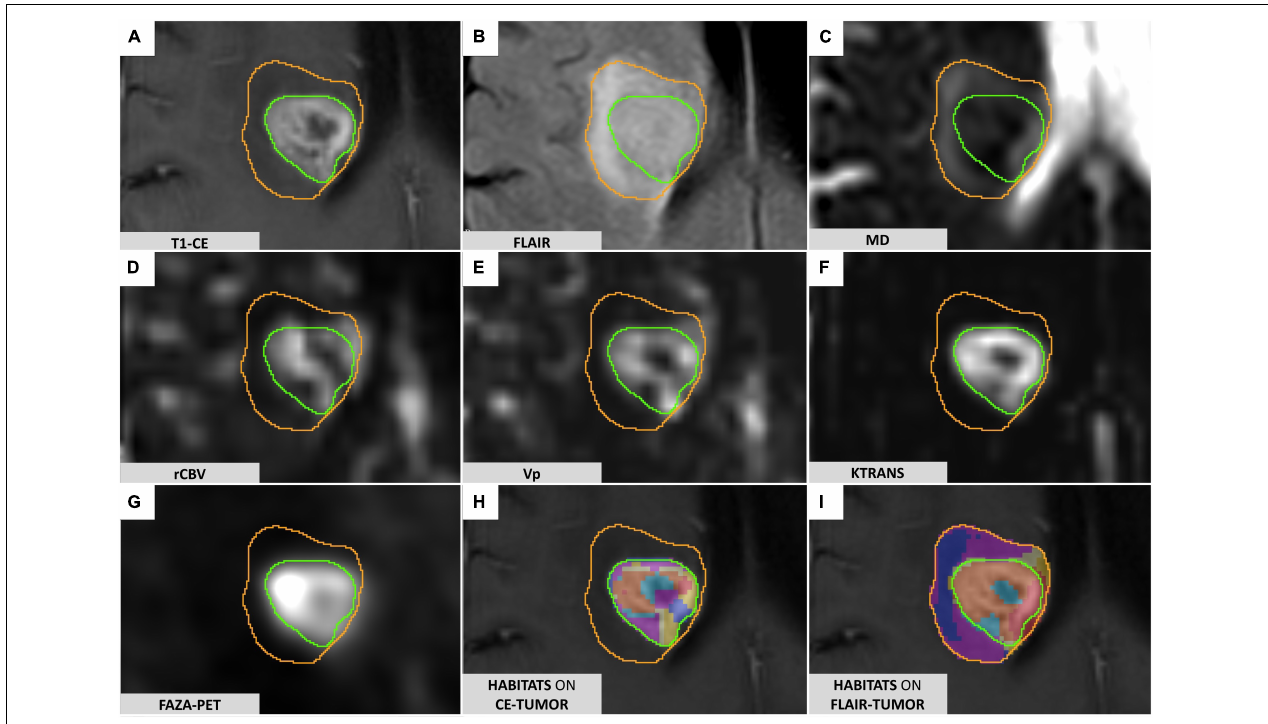
FIGURE 1 | FLAIR-tumor and CE-tumor segmentations on different MRI sequences. (A) T1-weighted contrast-enhanced imaging: the CE-tumor volume is contoured in green, including the enhancing tissue and necrotic core only. (B) FLAIR images: FLAIR-tumor is contoured in orange, including both the CE-tumor and the peritumoral hyperintensity. (C) MD map elaborated from DTI acquisition. (D) rCBV map elaborated from DSC MR perfusion acquisition. (E) VP map elaborated from DCE MR perfusion acquisition (F) Ktrans map elaborated from DCE MR perfusion acquisition. (G) 18F-FAZA-PET uptake showing hypoxic areas. (H) Prototype of clusters resulting from the application of the spatial habitat imaging algorithm only to the contrast-enhanced tumor volume (CE-tumor); clusters obtained this way were considered too small and fragmented in order to be reliably correlated to histology, and therefore not suitable for the purpose of the present study. (I) Habitats obtained applying the spatial habitat imaging algorithm to the FLAIR-tumor volume (which included the contrast-enhanced tumor core along with the surrounding area of FLAIR hyperintensity) were able to divide the whole tumor in a more reproducible way, with larger clusters amenable to a reliable histological correlation with the bioptic samples obtained; for the aforementioned reasons we selected FLAIR-tumor as the final tumor mask to be investigated and all the results presented in our paper are based on its analysis.